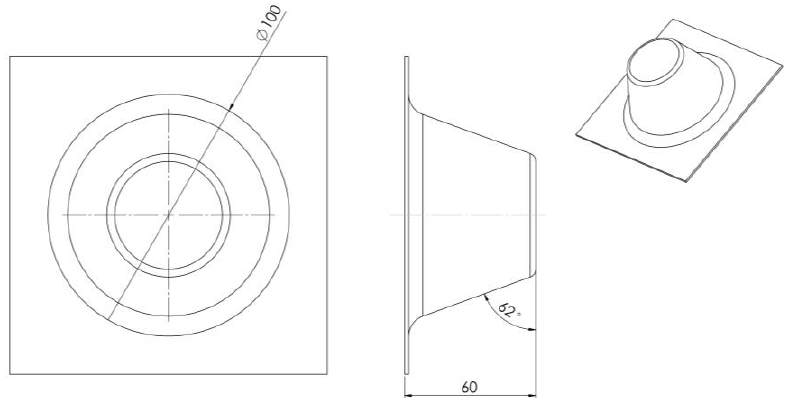
Figure 4. CAD model of cone shapes used in this study.